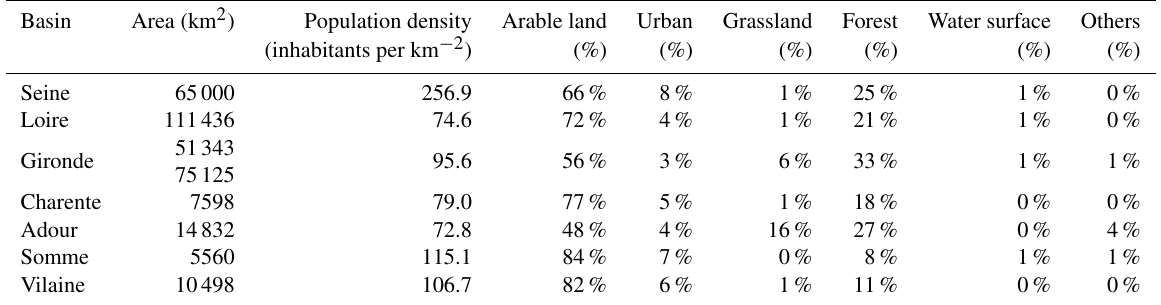
Table 2. Population density (INSEE, 2014) and land-use-type percentage (CORINE Land Cover, 2018) of the river basin of the systems studied. Basin Area (km 2 ) Population density Arable land Urban Grassland Forest Water surface Seine 65000 Loire Gironde Charente Adour Somme